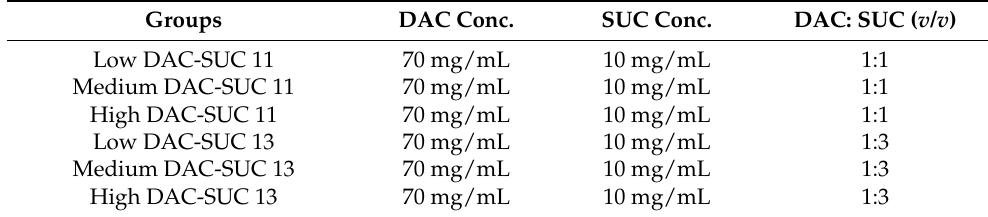
Table 2. DAC-SUC hydrogel preparation parameters. Groups DAC